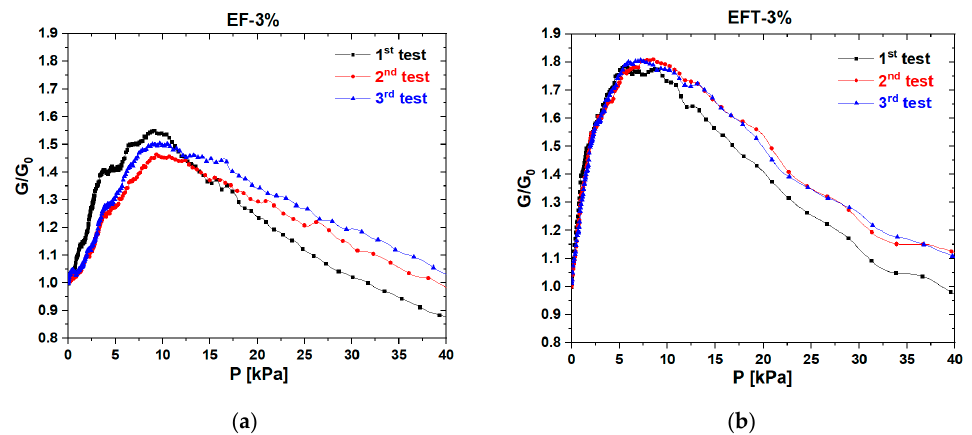
Figure 9. Normalized conductance vs. pressure obtained during three consecutive quasi-static monotonic loading tests at a speed of 0.1 mm / min: response of EF-3% ( a ) and EFT-3% ( b ) samples.